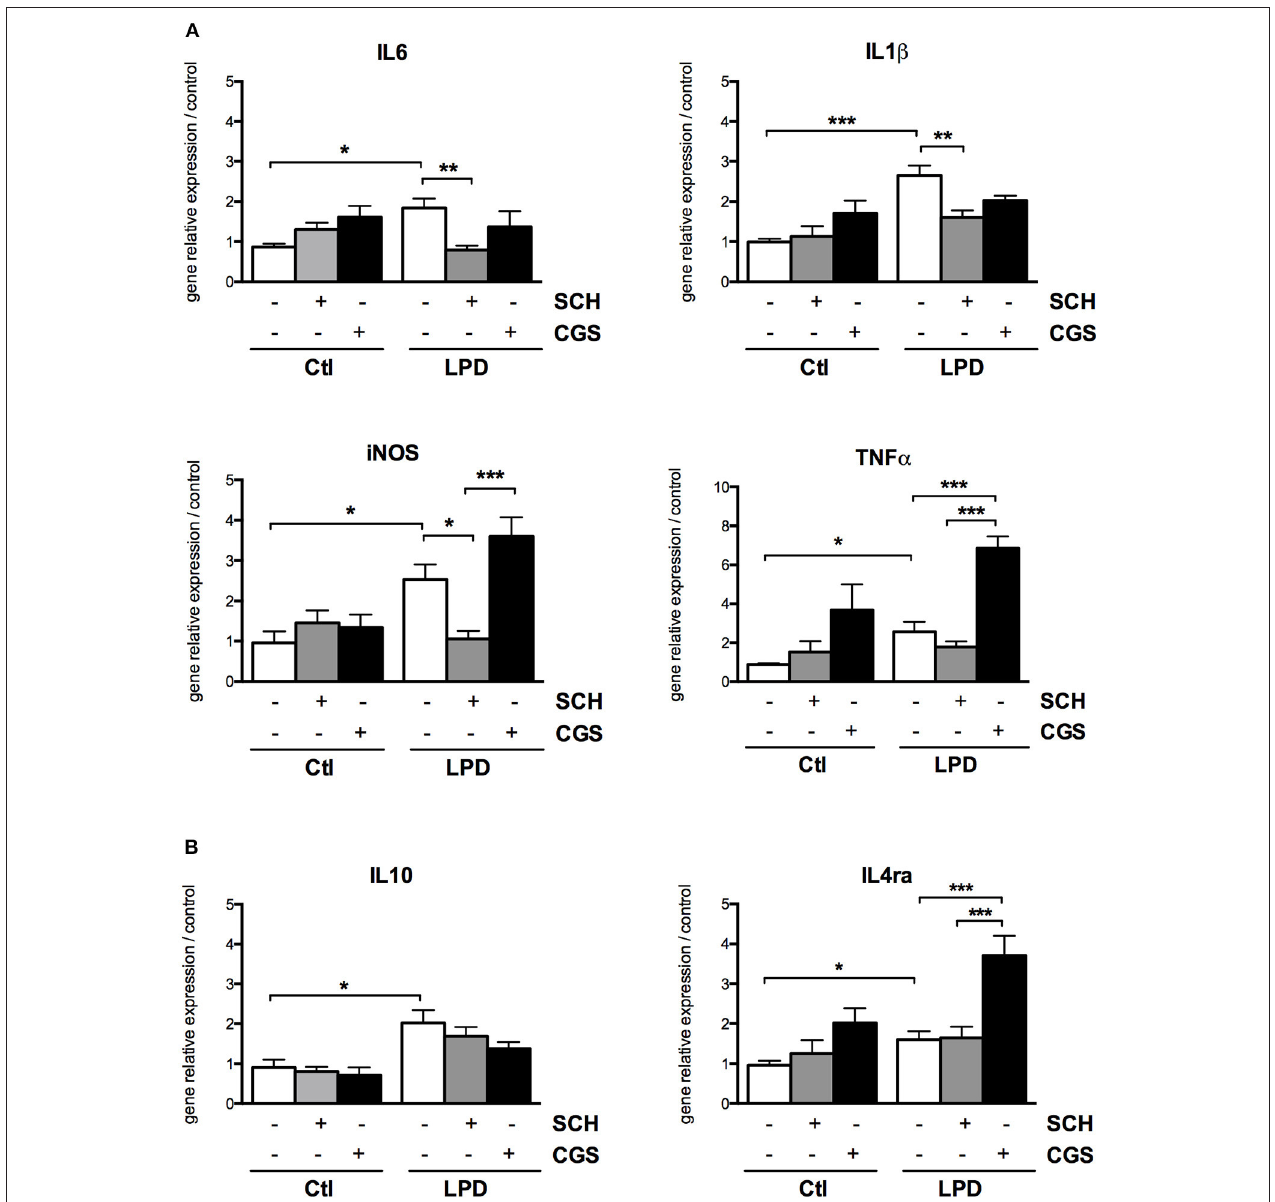
FIGURE 5 | A2aR modulation regulates the phenotype of microglial cells sorted from LPD animals. Quantification of gene relative expressions of M1 (A) and M2 (B) proteins in microglial cells treated with or without SCH-58261 (A2aR antagonist) and CGS-21680 (A2aR agonist) sorted from control or LPD animals (* p < 0.05, ** p < 0.01, *** p < 0.001, using one-way ANOVA followed by Newman-Keuls post-hoc